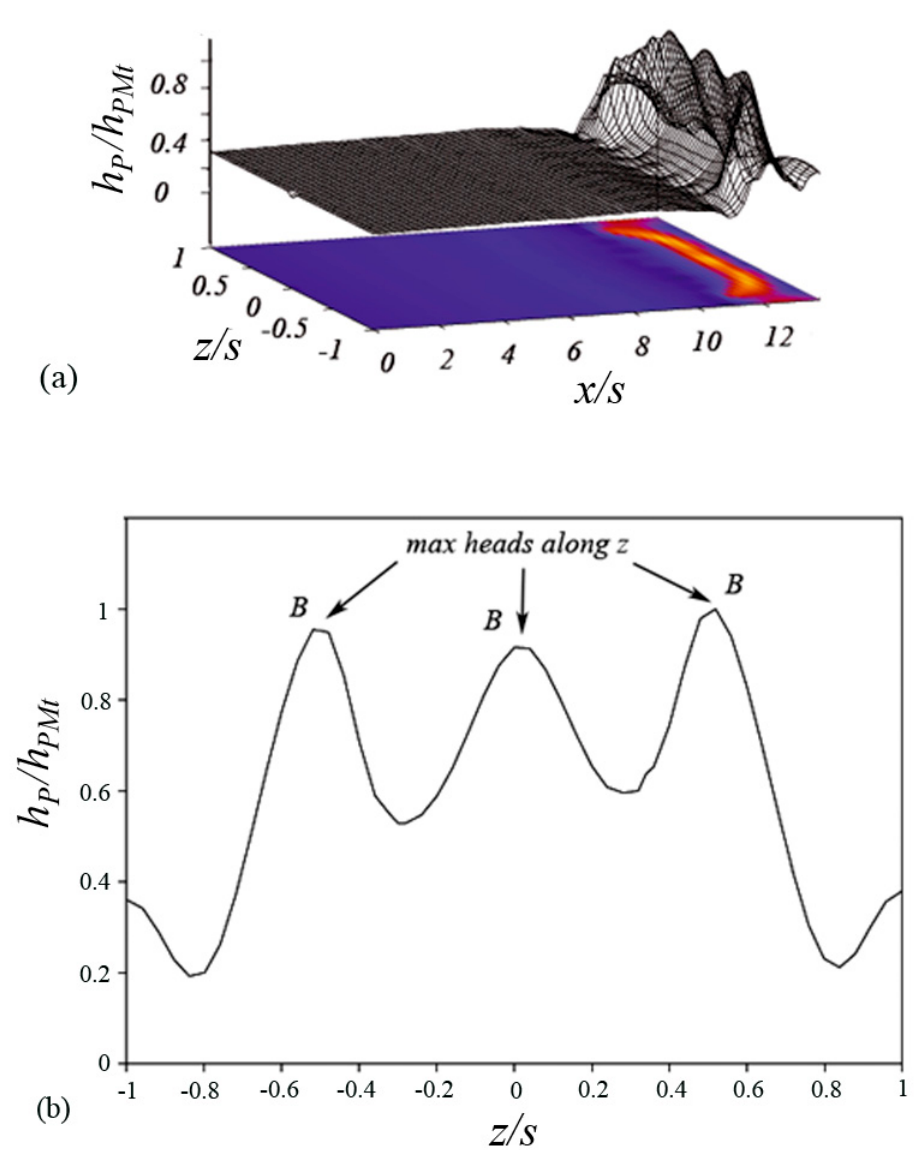
Figure 8. Behavior of the dynamic pressure head on the tailwater channel for F 0 = 10 and R = 0.10 m, β = 40°, h 0 = 0.05 m, test no. 27 in Table 1: ( a ) three-dimensional depiction of nondimensional dynamic pressure head; ( b ) distribution of nondimensional dynamic pressure head along the z -axis.